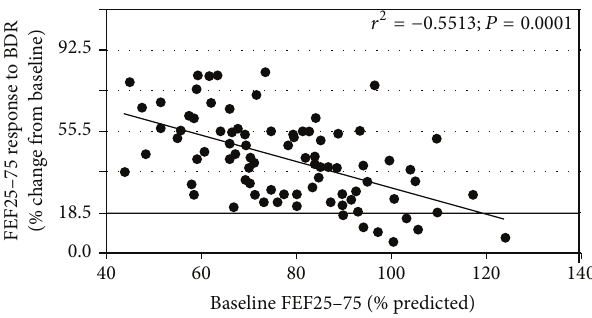
Figure 2: Correlation between airway obstruction severities assessed by FEF25–75 and the response of this index to